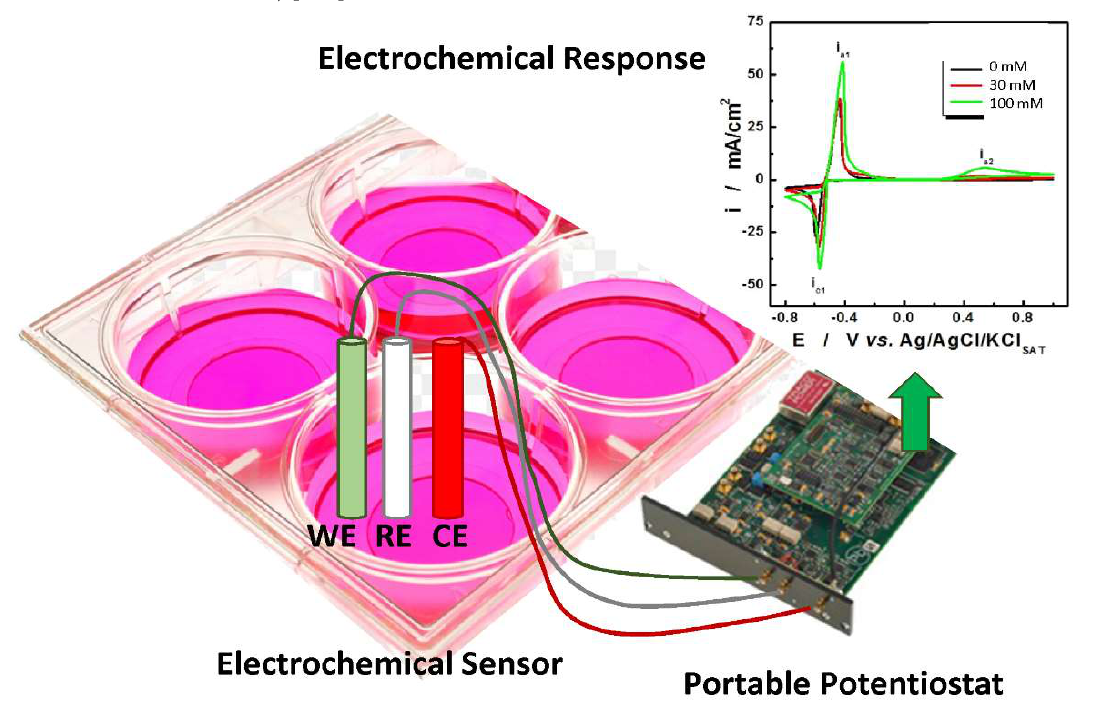
Figure 2. Real-time electrochemical detection of markers of oxidative stress in a culture plate.